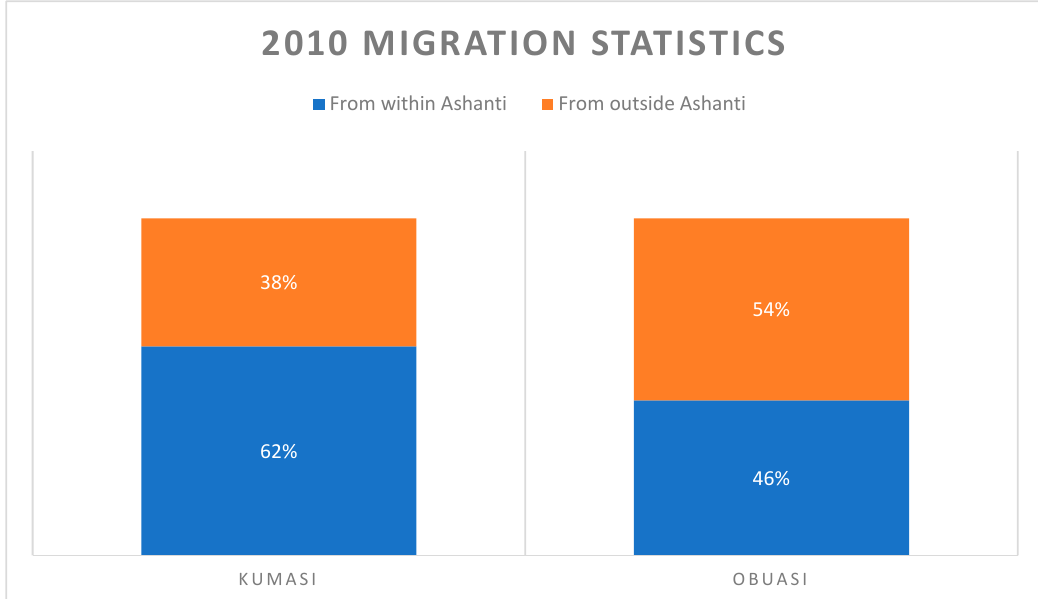
Figure 6. Proportion of migrants born within or outside Kumasi and Obuasi in 2010. Source [80–83].